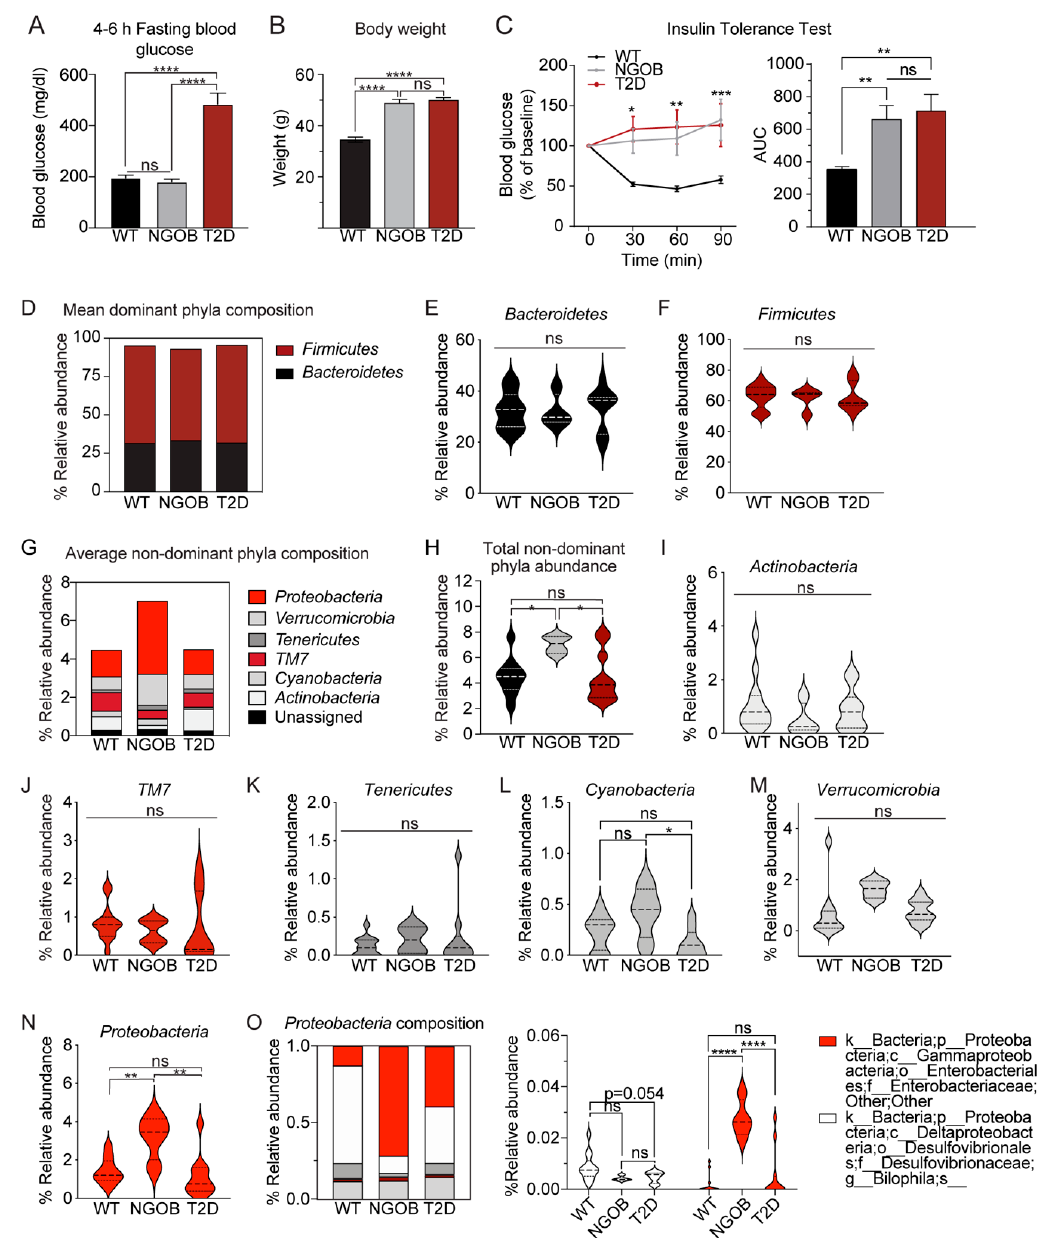
Figure 3. Gut microbiota diversity is associated with diabetes protection: ( A ) 4–6 h fasting blood glucose recordings of wild-type (WT) normoglycemic obese (NGOB) and diabetic (T2D) mice n = 6–15; ( B ) WT, NGOB, and T2D bodyweight at 10 weeks of age, n = 7–14; ( C ) insulin tolerance test of WT, NGOB, and T2D mice, with data plotted as a percent of baseline (t = 0 min) and quantified by the area under the curve (AUC) from zero and with data representing mean ± SEM, ns = not significant. ( D ) bar plot of dominant phyla; ( E , F ) violin plots of individual phyla; ( G ) bar plot of nondominant phyla; ( H ) average relative abundance of nondominant phyla; ( I – N ) violin plots of individual phyla; and ( O ) species composition of proteobacteria (left) and individual relative abundance of each proteobacteria species (right), n = 4–10. Data represent mean ± SD and population density. * p < 0.05, ** p < 0.01, *** p < 0.001, and **** p < 0.0001. ns = not significant.